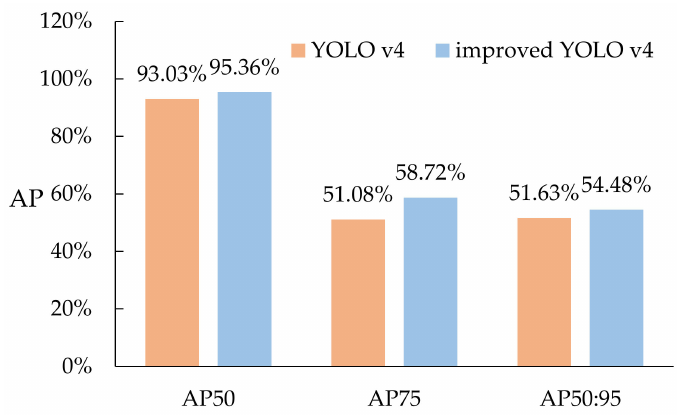
Figure 9. Contrast graphs of the improved algorithm results.